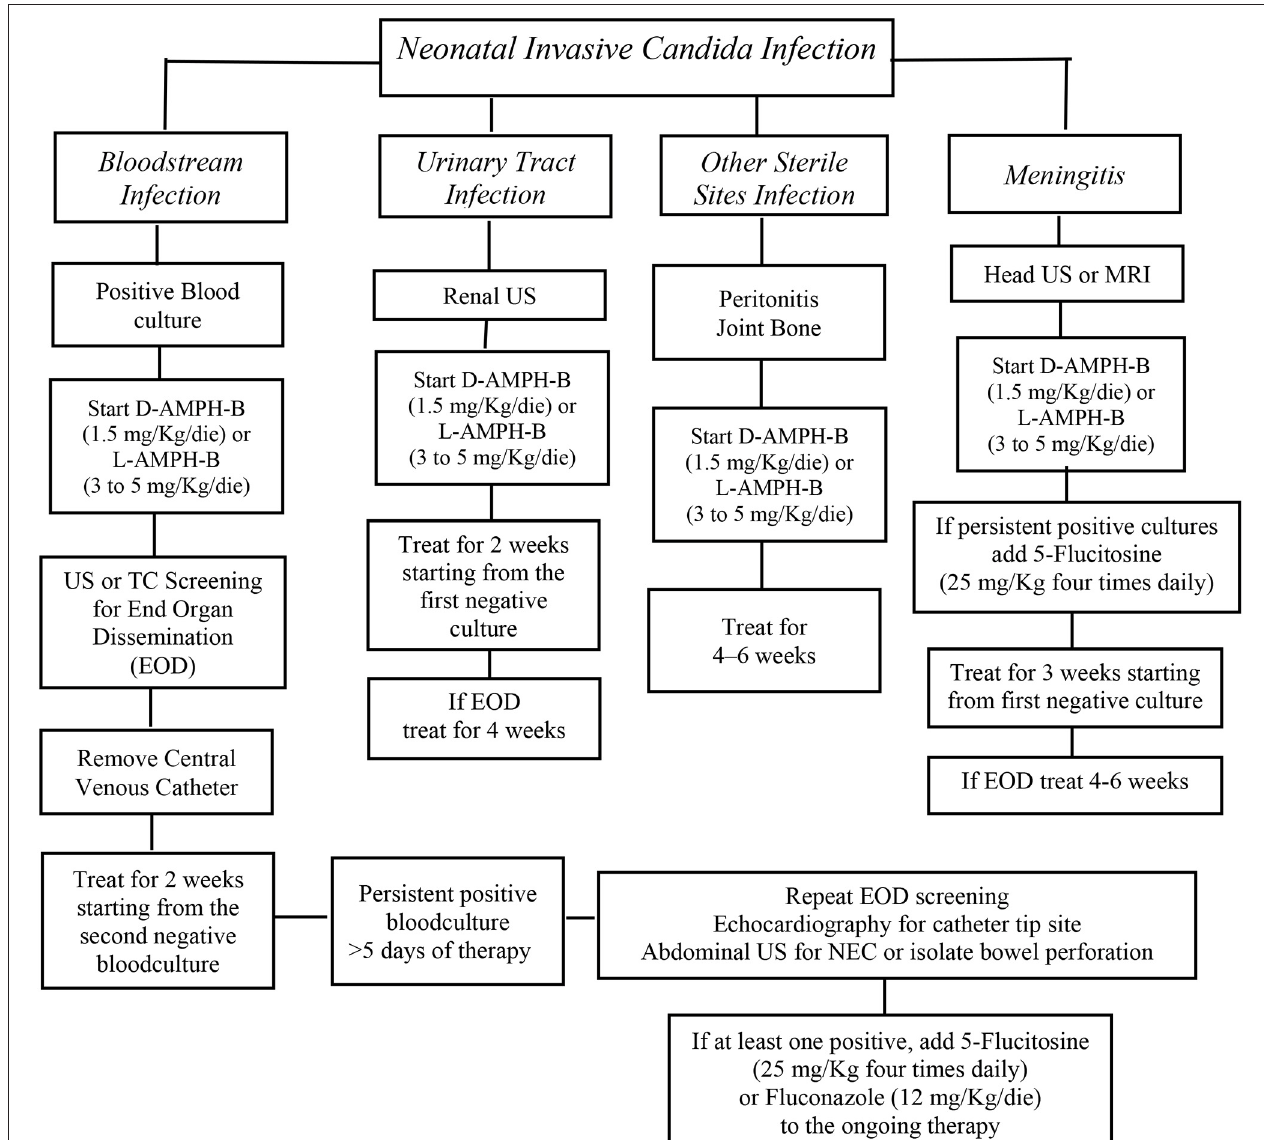
FIGURE 1 | AmB deoxycholate should be started at 1 mg/kg intravenous daily and can be increased up to 1.5 mg/Kg/die. An alternative option is liposomal AmB that should be started at 3–5 mg/kg daily. The addition of 5-flucytosine 25 mg/kg four times daily at should be considered as salvage therapy in patients not responsive to initial AmB therapy or with End Organ Dissemination (EOD). Fluconazole, 12 mg/kg daily, is recommended for Candida strains that are susceptible to fluconazole, in babies who had not a previous fluconazole prophylaxis. Algorithm for the initial treatment of Invasive Candida Infections in neonates [from (28),